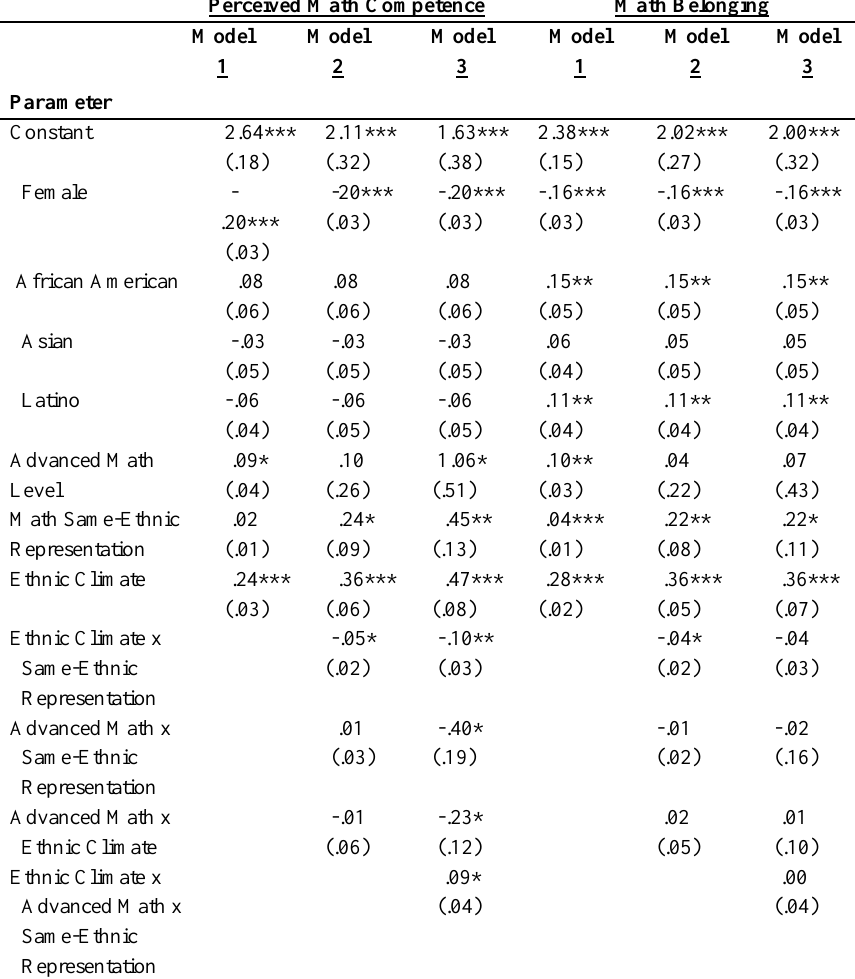
Hierarchical linear model results for perceived math competence and math belonging